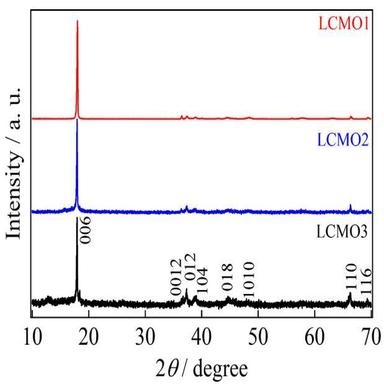
X-ray diffraction patterns of LCMO1, LCMO2, and LCMO3.